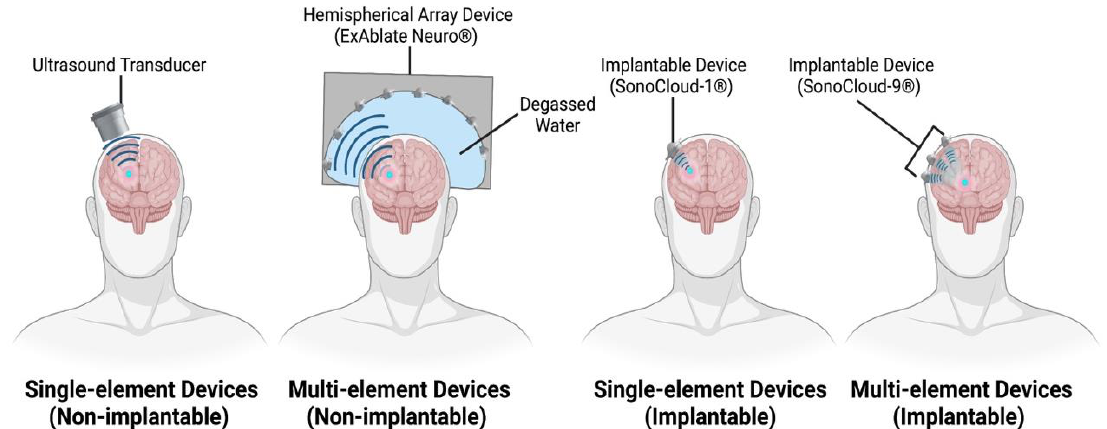
Figure 3. Comparison of therapeutic ultrasound devices used for BBB disruption. ( Created with Biorender.com (accessed on 12 March